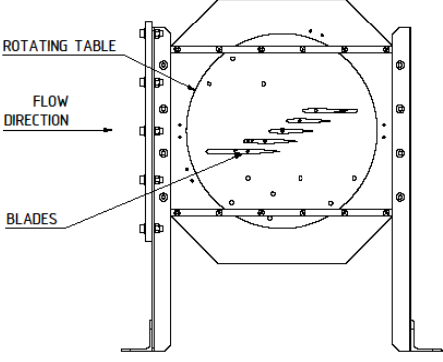
Fig. 1. Assembly of the blade cascade with a rotary disc.